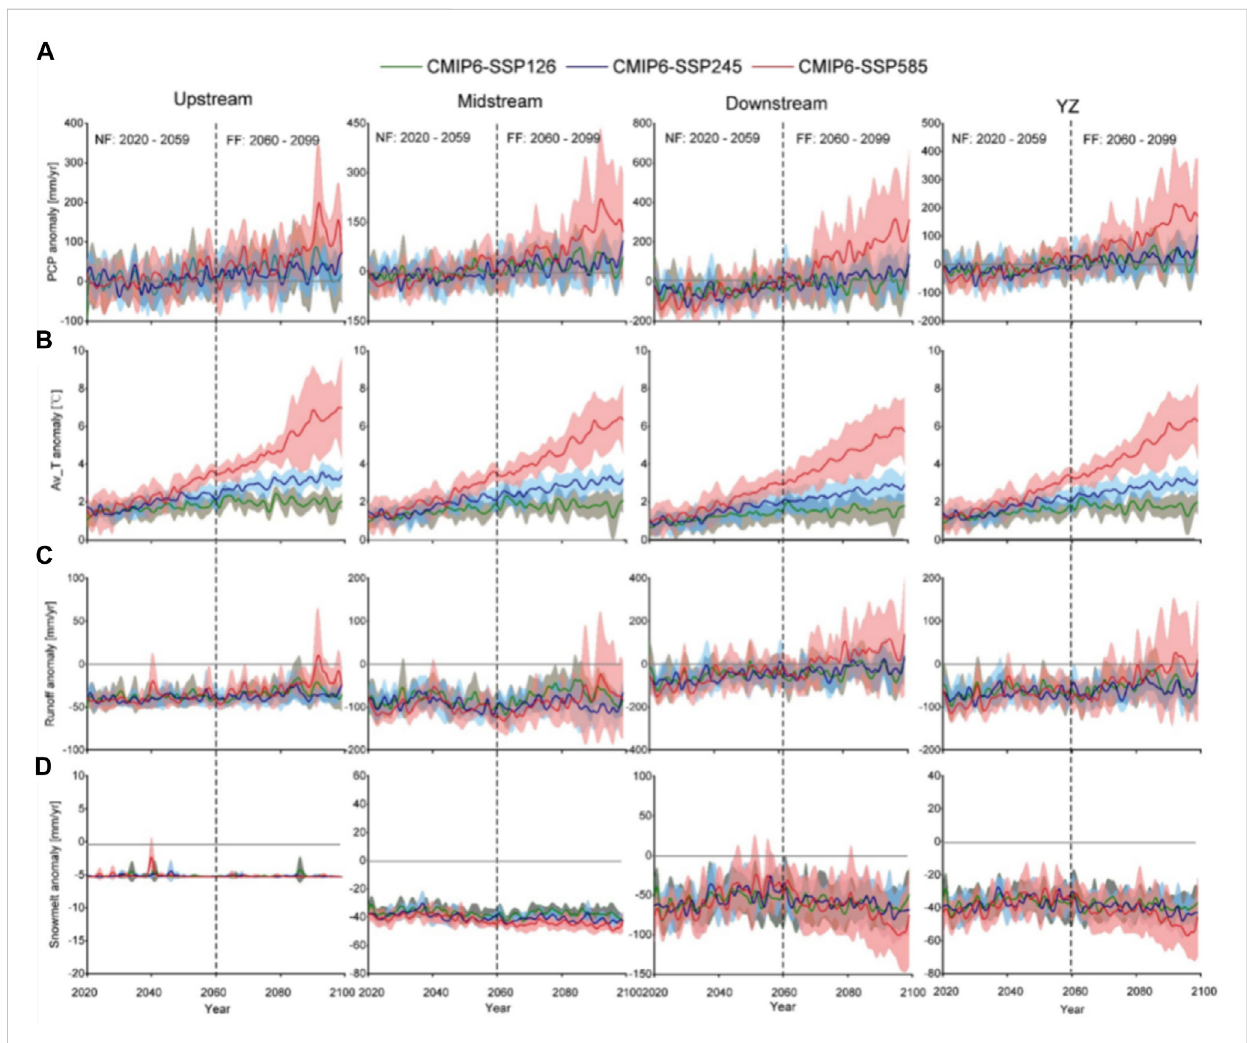
FIGURE 6 The anomalous statistics from the historical multi-year average of (A) average annual precipitation, (B) average temperature (Av_T), (C) runoff, and (D) snowmeltintheupstream,midstream,downstream,andYZBinthenearfuture(NF:2020 – 2059)andfarfuture(FF:2060 – 2099)underthreedifferent scenarios of CMIP6 (SSP126, SSP245, and